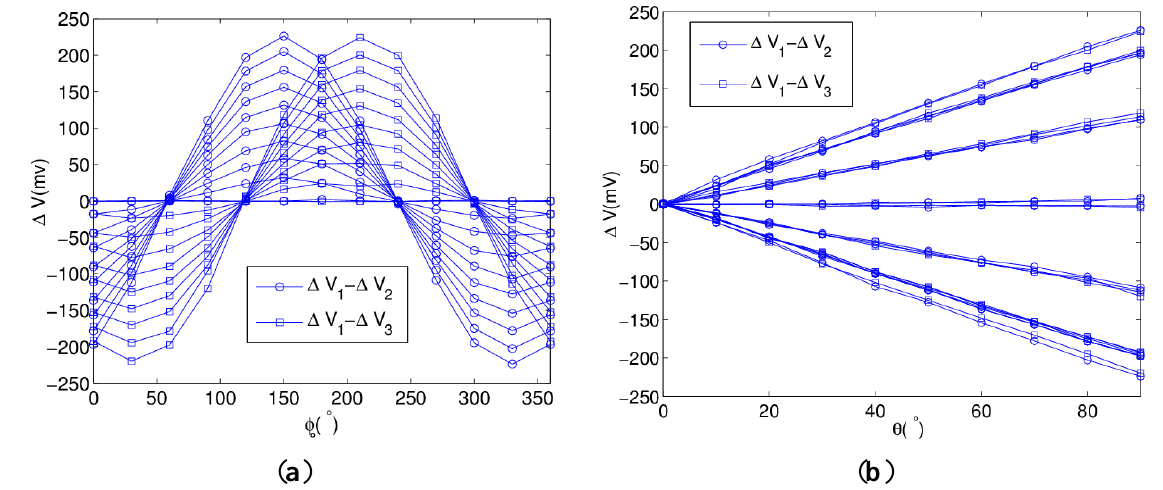
− ∆ V and ∆ V − ∆ V : 1 2 1 3